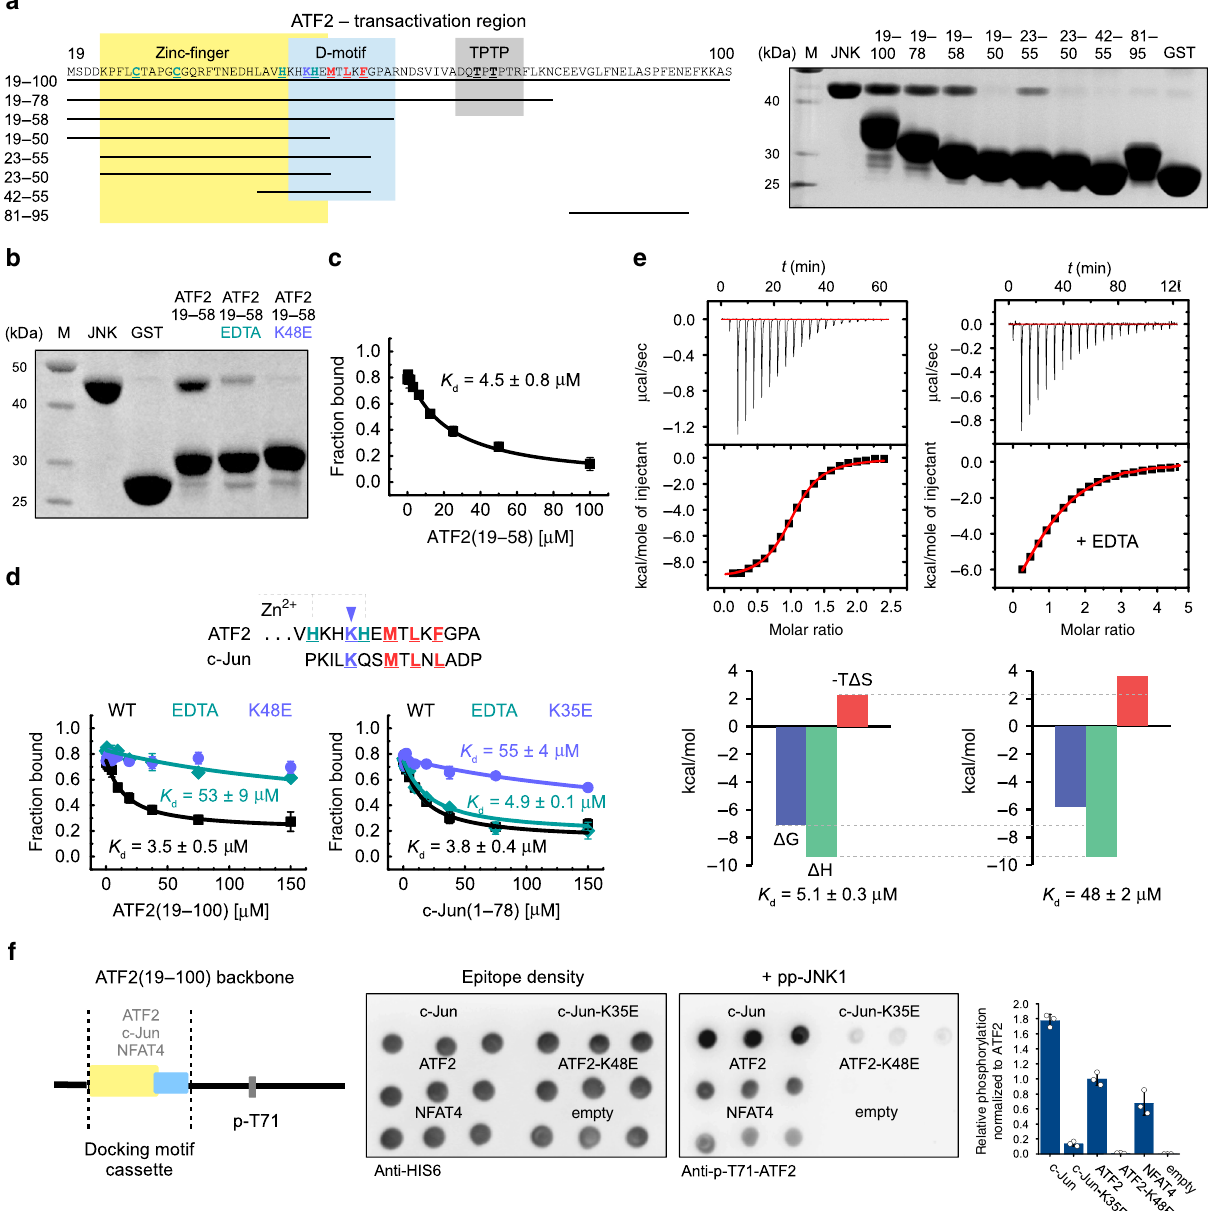
Fig. 1 JNK-ATF2 binding depends on an intact Zn- fi nger + D-motif module. a Mapping of JNK1 binding to ATF2 by GST pull-down. Interaction of recombinant expressed and puri fi ed bait and prey was detected on Coomassie stained SDS-PAGE. GST control was used as negative control to assess unspeci fi c binding of the prey (GST; M — molecular weight marker, JNK — load). The experiment was repeated independently at least three times with similar results. b GST pull-down experiment with JNK1 (prey) and GST-ATF2(19 – 58) (bait). The binding mix contained 2 mM EDTA or the bait had a lysine to glutamate mutation (K48E). c Result of a competitive fl uorescent polarization-based binding assay. Error bars on the binding isotherms show SD based on three independent measurements ( n = 3). Data are represented as mean values± SD. d Binding of JNK1 to MBP-ATF2(19 – 100) and MBP-c-Jun(1 – 78) fusion proteins in the presence of EDTA, or when lysine residues (K48E or K35E in ATF2 and c-Jun, respectively) were mutated. Error bars on the binding isotherms show SD based on three independent measurements ( n = 3). Date are represented as mean values ± SD. (MBP: maltose-binding protein fusion tag.) e ITC measurements of JNK1 and ATF2(19 – 58) binding in the absence or presence of 2 mM EDTA. Representative ITC data (upper panels) are shown with raw injection heats and the corresponding speci fi c binding isotherms. Lower panels show the enthalpic ( Δ H) and entropic ( − T Δ S) contributions to binding free energy ( Δ G). f Phosphorylation of ATF2 reporter constructs. GST constructs containing different docking motif cassettes were dotted on a membrane and incubated with activated JNK1 (pp-JNK1). Equal load was con fi rmed by Anti-His6 antibody, while phosphorylation of the probe was determined by Anti-p-T71-ATF2 immunoblots. (empty: no docking motif; NFAT4: the D-motif from NFAT4 was used as reference to former work 16 ). Error bars show SD from three technical replicates. Data points are represented as mean values ± SD. The experiment was repeated twice with similar results. Source data are provided as a Source data fi